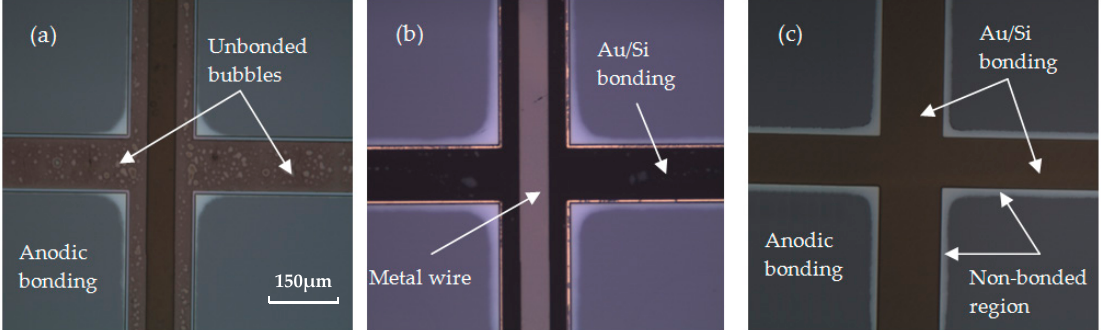
Figure 7. Optical microscope images for different metal layers. ( a ) Bonding with a Cr/Au layer, unbonded bubbles appeared in the bonding interfaces; ( b ) bonding with a Ti/Pt/Au layer, color of the metal layer changed due to the breakdown of the Pt barrier; ( c ) bonding with a TiW/Au layer, a stable bonding interface is achieved.